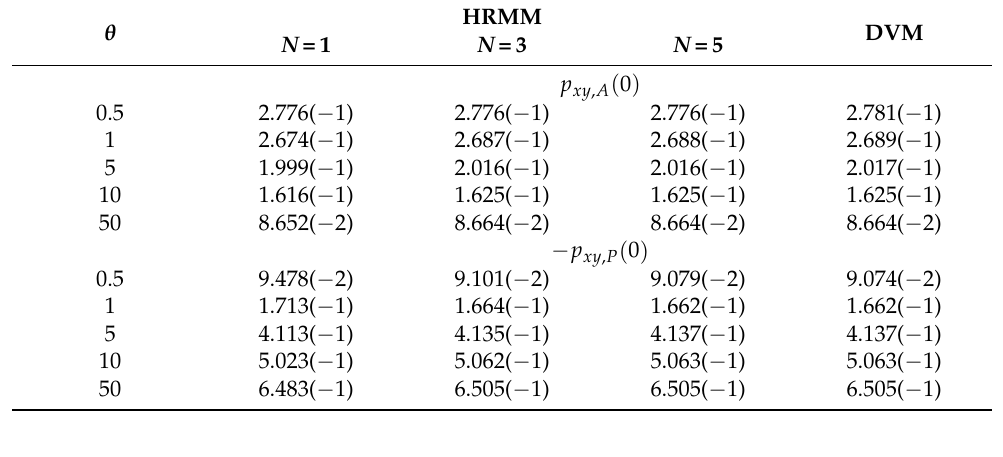
Table 2. Oscillatory Stokes flow; shear stress amplitude and phase (rad) at the oscillating wall ( y = 0) for various values of θ based on the HRMM, with N = 1,3,5 and the DVM.